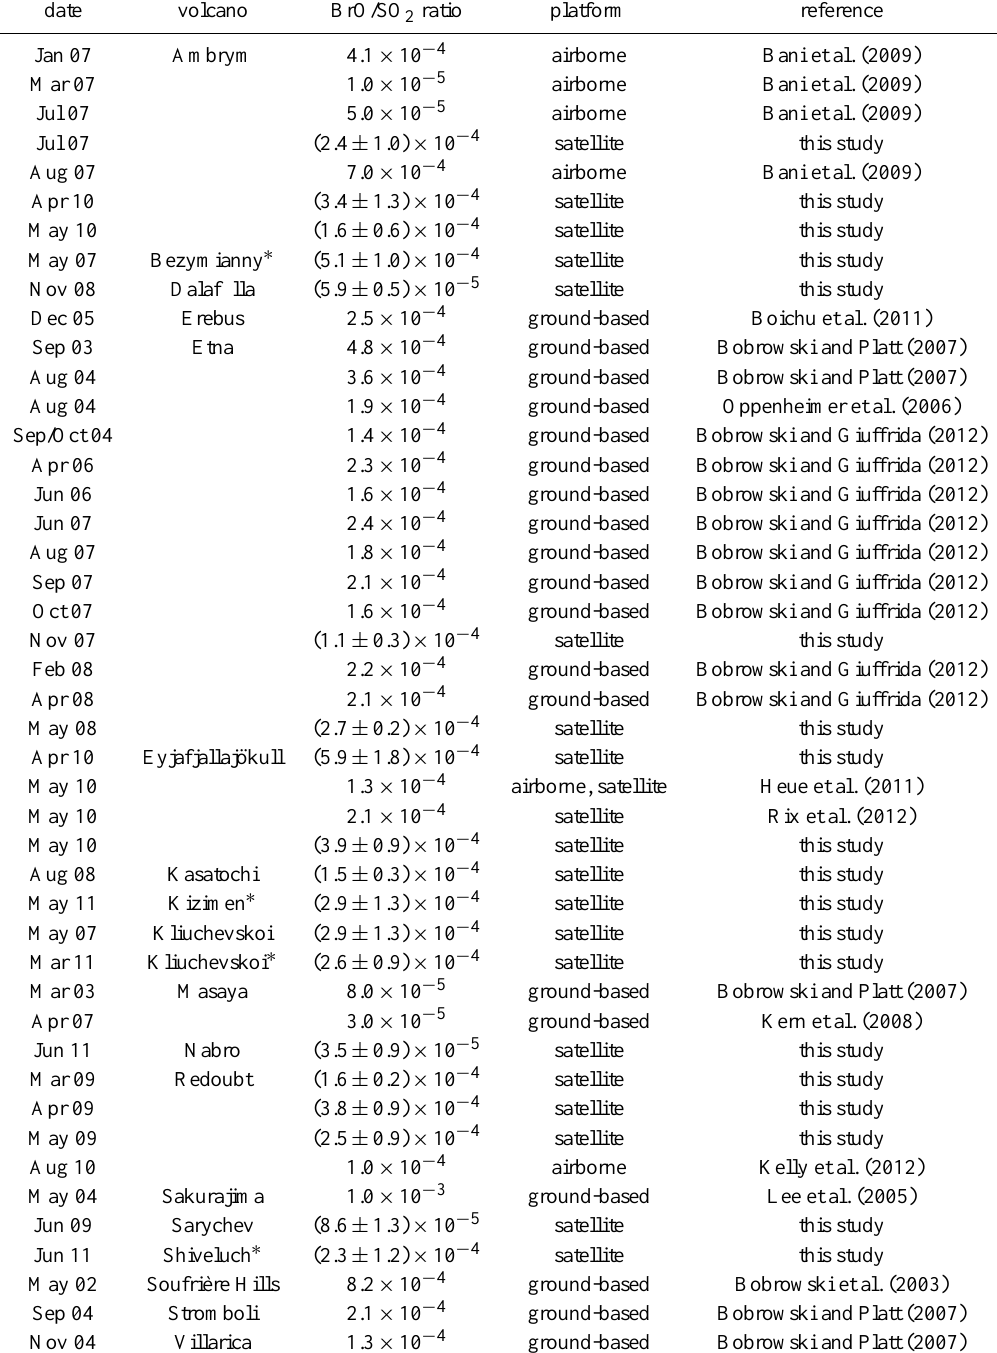
Table 7. Table of worldwide reported volcanic BrO observations for different platforms, including the results from this study. The observa- tions are sorted by the responsible volcano and the month of the corresponding measurements. For several measurements within a month, the maximum BrO/SO 2 ratios are always given (except Etna measurements by Bobrowski and Giuffrida (2012), showing mean ratios). Uncertain volcanoes are indicated by ∗